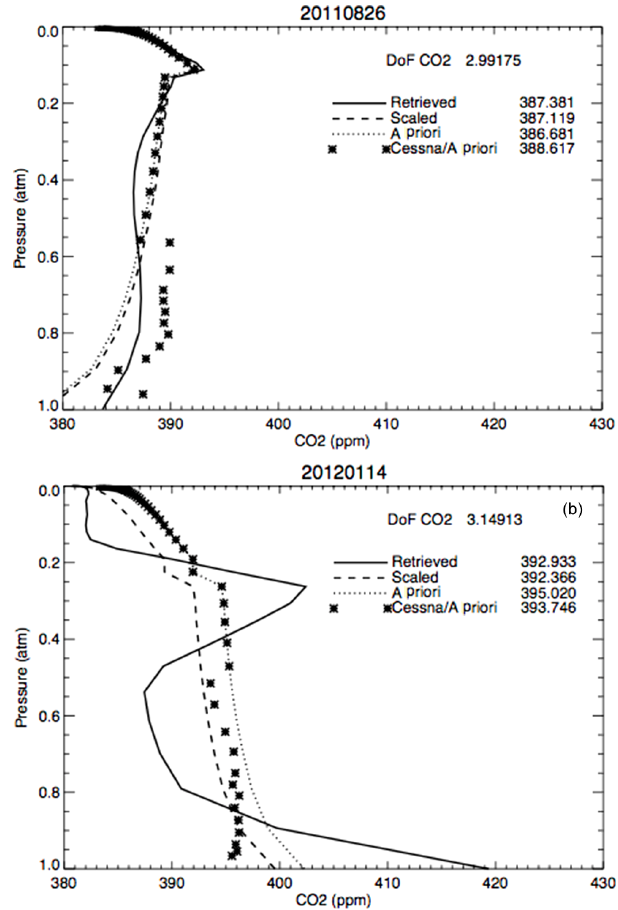
Figure 16. (a) As Fig. 14a but for 28 August 2011. (b) As Fig. 14b but for 14 January